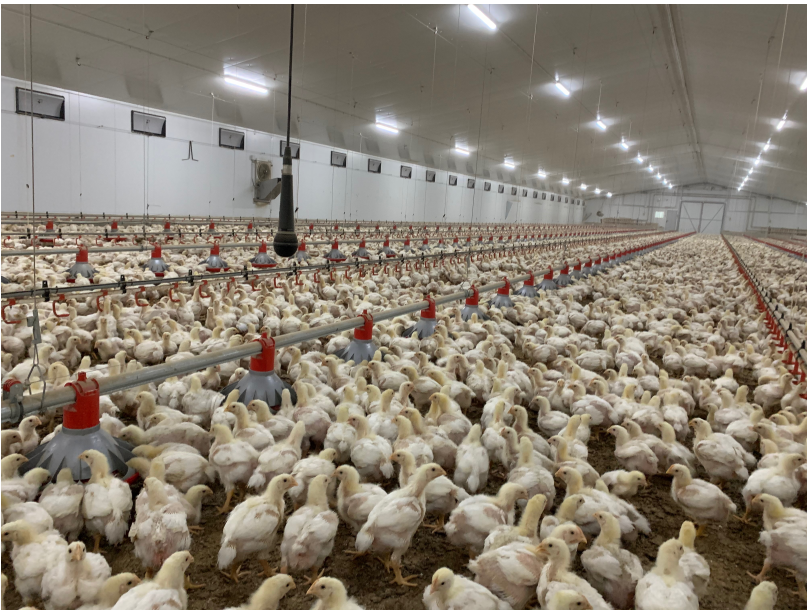
Figure 1. Picture of day 21 in H1 house. The birds live with the microphone installation. It is recording continuous raw acoustic